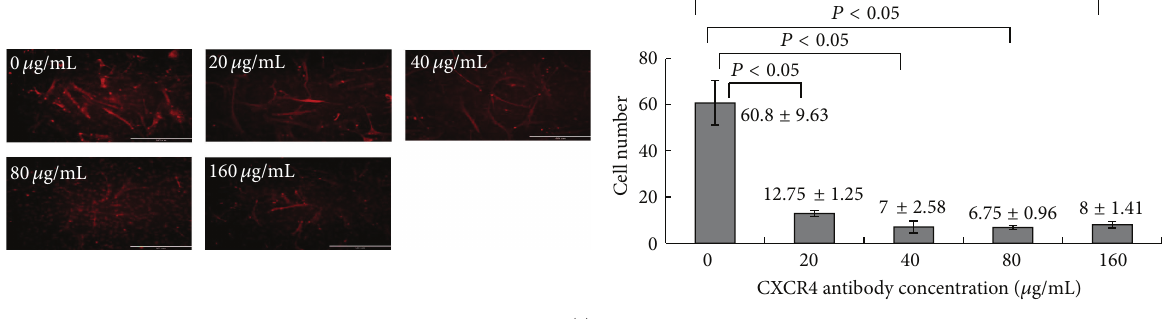
livers with cells injection through tail vein (TVI) was 516.10±